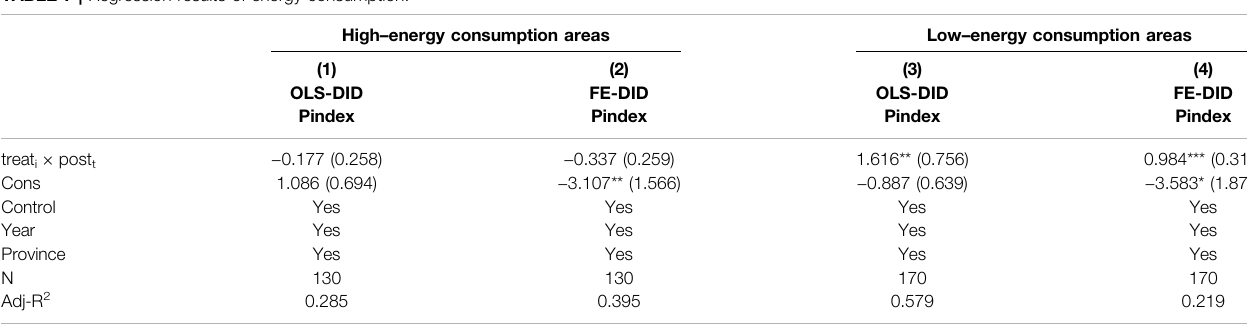
TABLE 7 | Regression results of energy